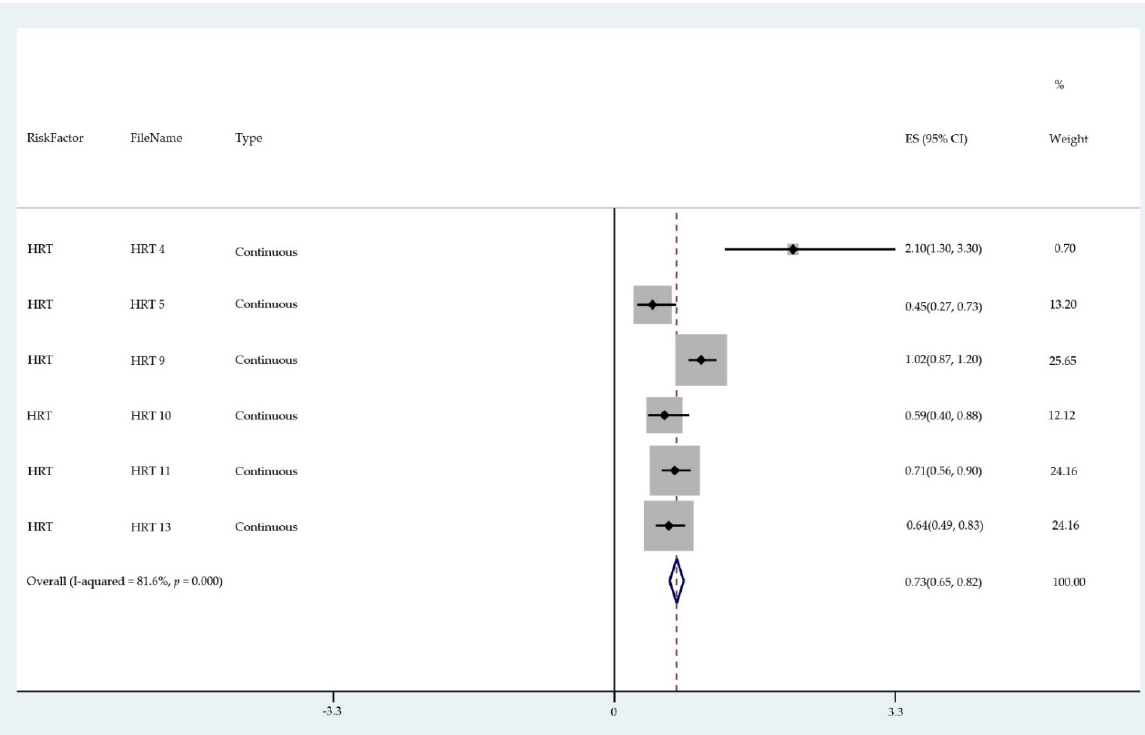
Figure 5. Forest plot to show risk of continuous HRT.